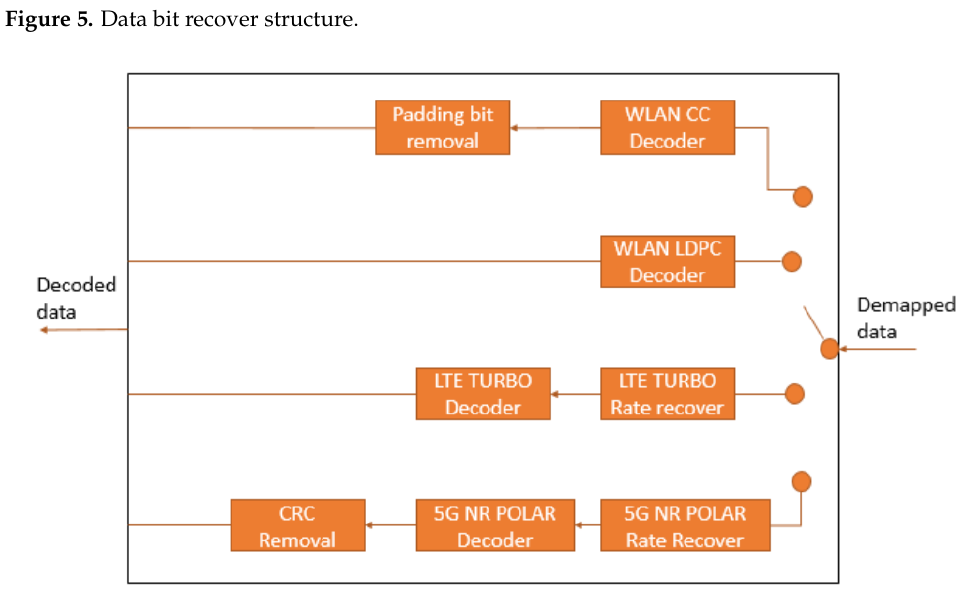
Figure 5. Data bit recover structure.